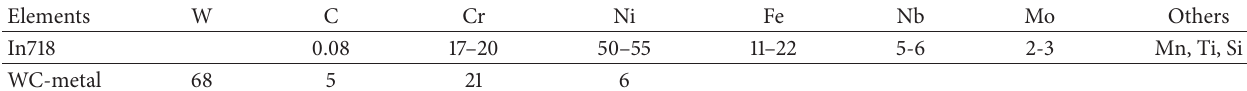
Table 1: Major chemical compositions of In718 and WC-metal powder.